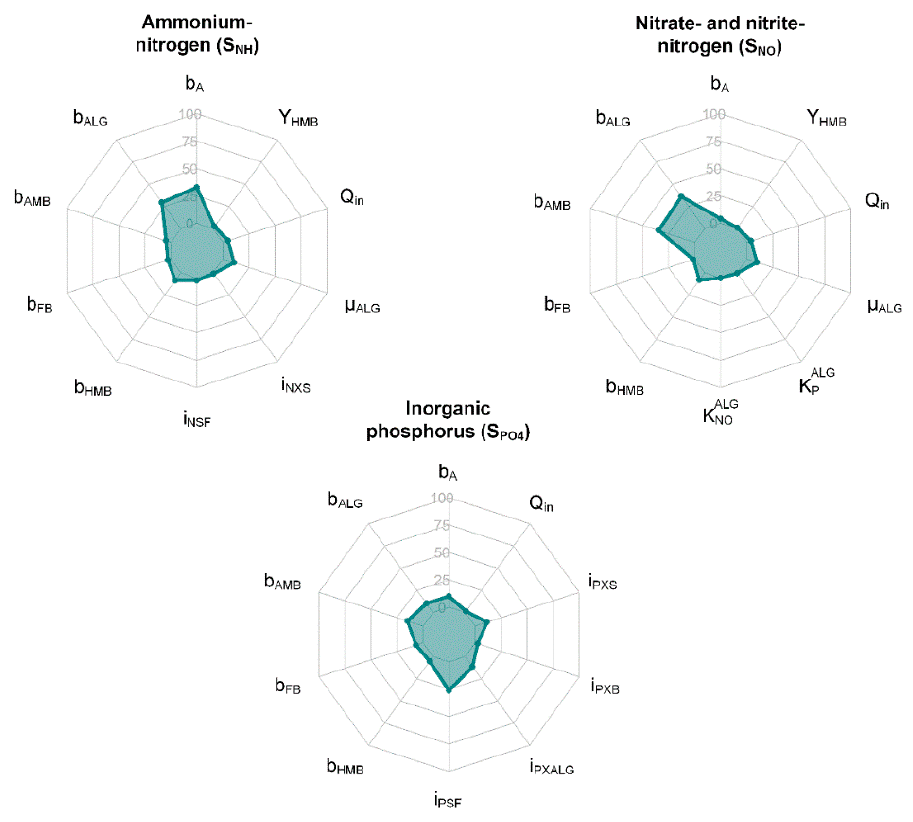
Figure 4. Ten most significant parameters influencing the variability of ammonium-nitrogen, nitrate- and nitrite-nitrogen, and phosphate in the waste stabilization pond (WSP) systems. The results in the radar graphs are the proportion of sensitivity function ( s ij ) for the state variable against the changes of each model parameter over the total sum of sensitivity measures. The description of the influential parameters in the graph can be found in the Supplementary Material F.